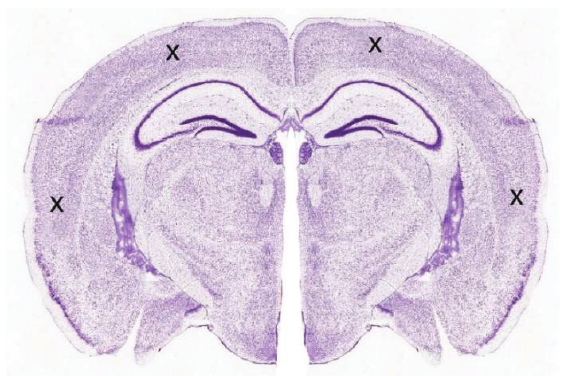
Figure 6. Coronal rodent slice showing the approximate recording electrode arrangement (marked by the crosses).